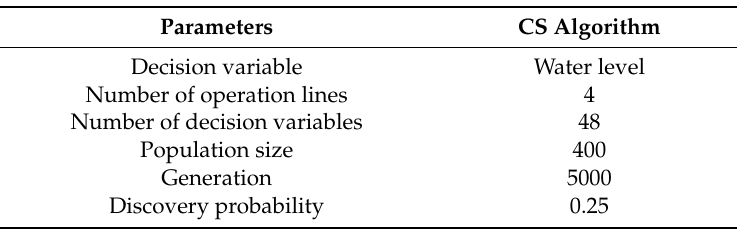
Table 2. Parameters for the solution